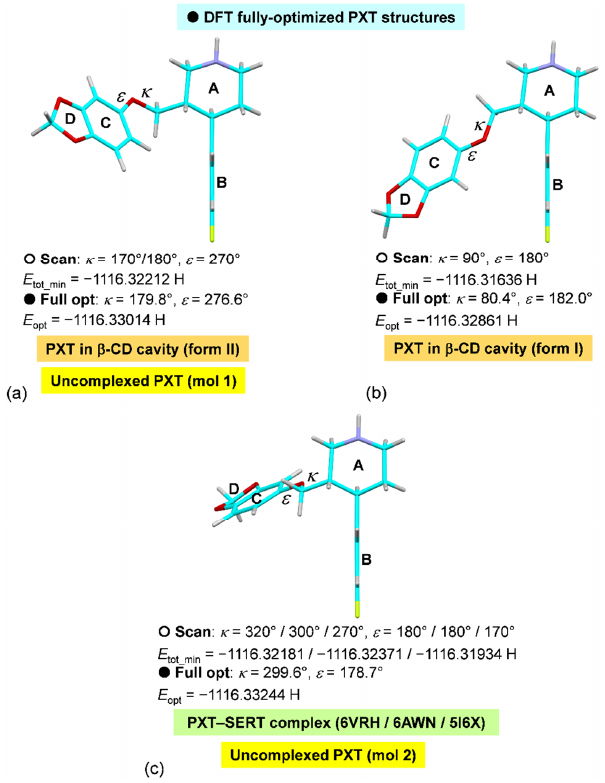
Figure 9. Fully optimized PXT structures from DFT calculation in the gas phase. The starting struc- tures are taken from the PES rigid scan of PXT in three varied crystal lattices, including ( a , b ) PXT encapsulated in the β-CD cavity and ( c ) PXT bound to the central site of SERT. Note that the un- complexed PXT comprises two molecules in the asymmetric unit, of which their torsion angles κ and ε are mostly identical with PXT (II) and PXT (6AWN); see text for more details. The coordinates ( κ , ε ) of PXT from PES rigid scan ( ) and full optimization ( ) together with E tot_min and E opt from DFT calculations are given; see Figure 8 for the PESs of PXT and Table 3 for the summary. To sum up, we can infer from the PES profiles depicted in Figure 8 as follows: (i) PXT (II) at ( κ , ε) = (170°, 270°) is the most stable and is 3.16 kcal mol −1 more stable than PXT (I), (cid:35) which is the least stable with rather high E tot_min at ( κ , ε) = (90°, 80°) (Figure 9a,b). This implies that the unstable U-shaped structure of PXT (I) is stabilized when encapsulated in the β-CD cavity. (ii) PXT in the HBr salt form comprises two thermodynamically stable molecules, which are equivalent to PXT (II) and PXT–SERT. This is evidenced by the co- incident ( κ , ε) coordinates of the X-ray, PES scanned and fully optimized structures (Fig- ure 9a,c). (iii) From PES scans, the X-ray structures of PXT–SERT (5I6X, 6AWN and 6VRH) are the more to most energetically stable conformers (Figure 9c). After energy minimiza- tion, the three optimized structures of PXT in complex with SERT are identical with the